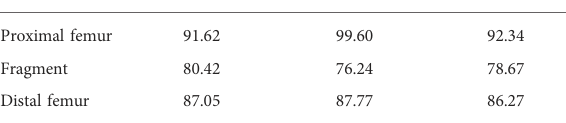
TABLE 2 Segmentation accuracy in 7 testing cases from the local